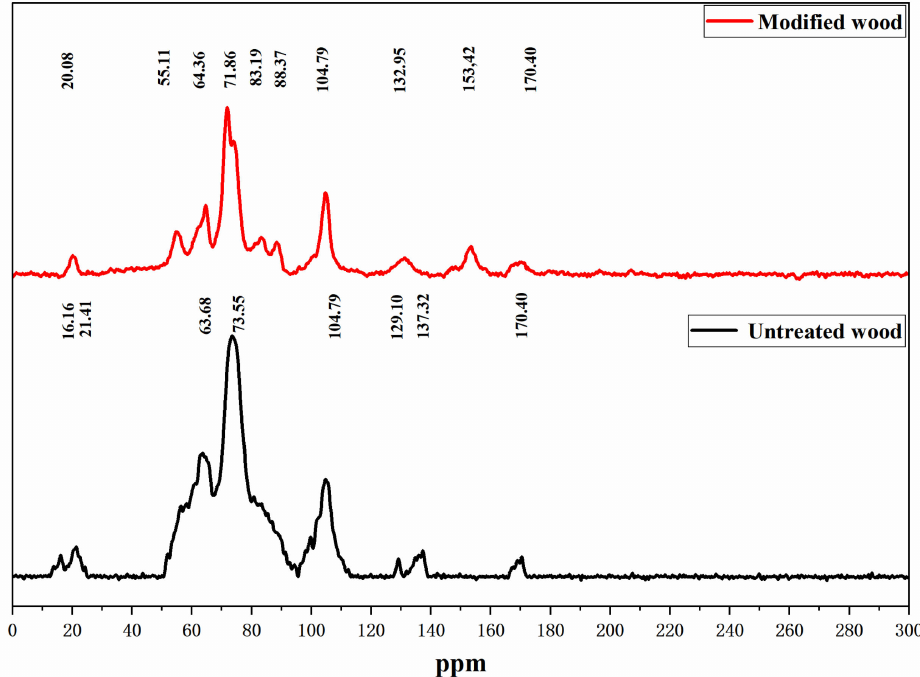
Figure 5. NMR spectra of untreated and treated